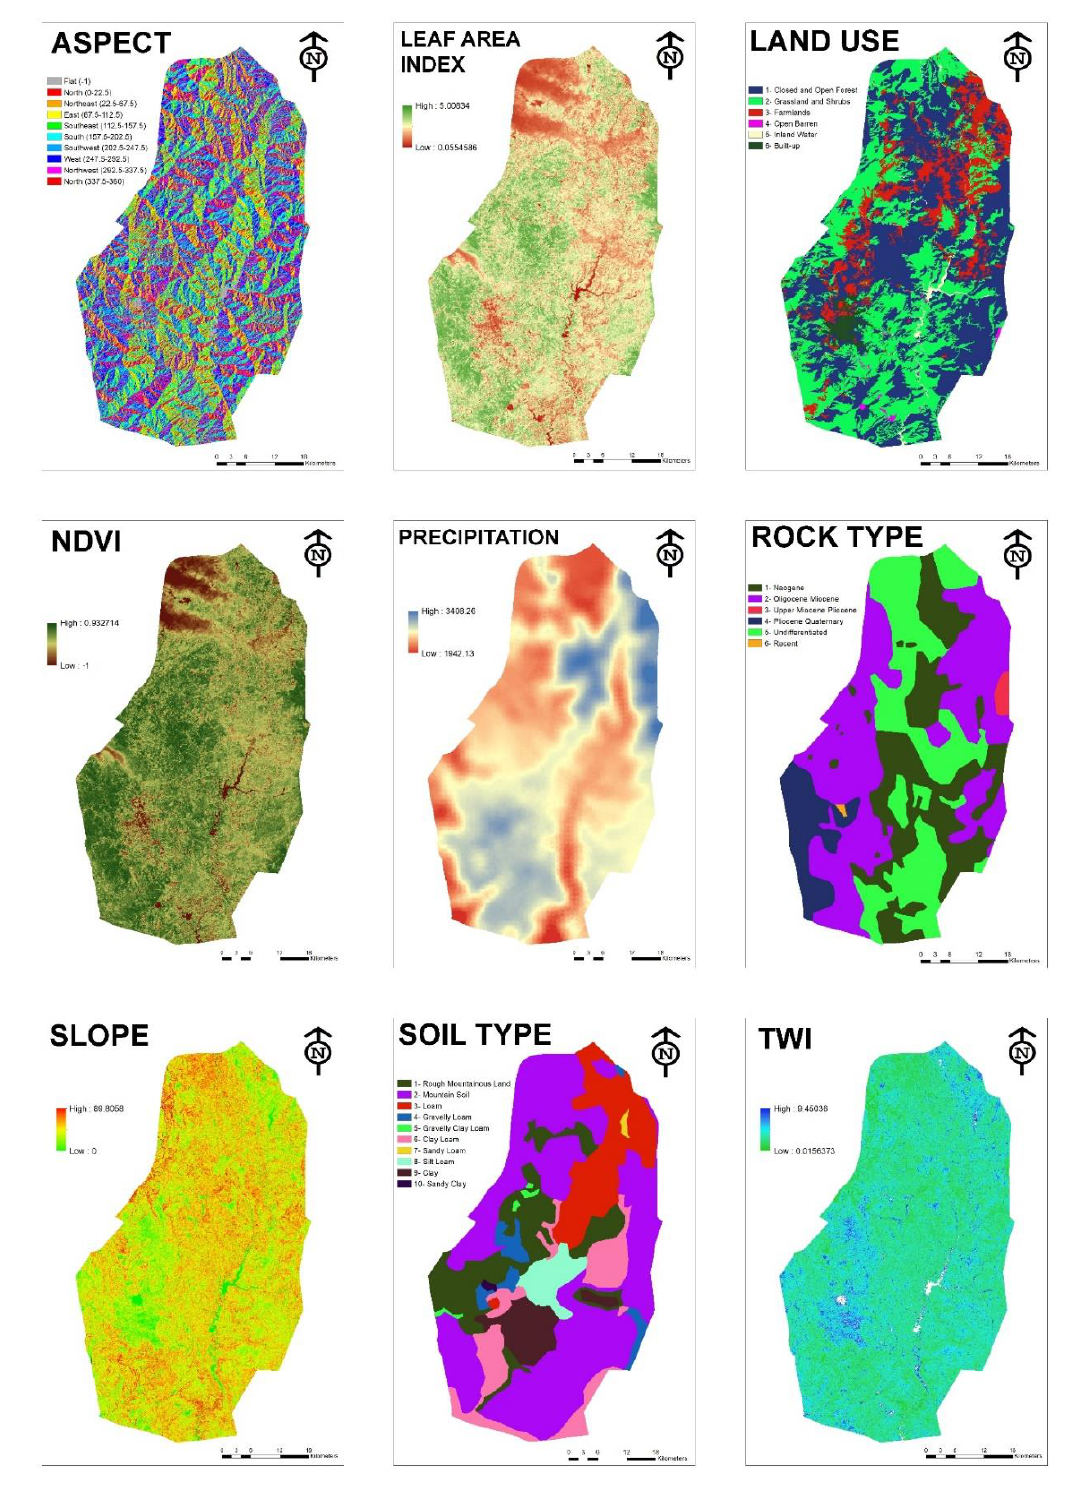
Figure 4. Thematic maps of the independent variables